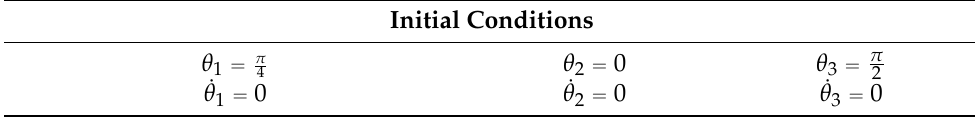
Table 1. Initial conditions for proposed model.